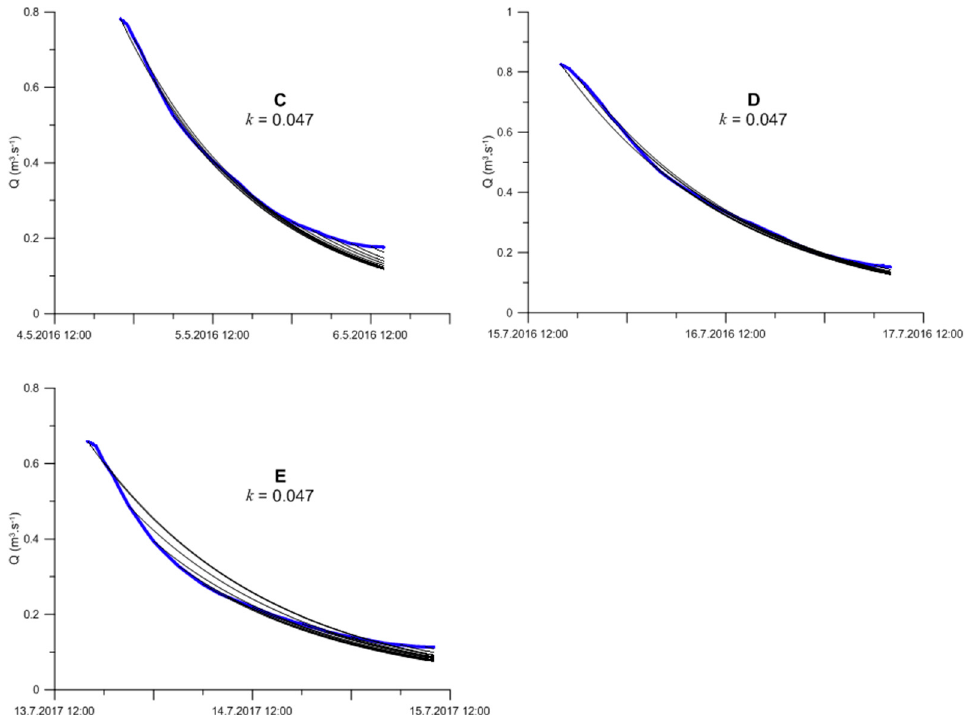
Figure 4. Plot of measured discharges (blue line) and discharges simulated using the global average value of recession constant for different starting points on the falling limb (black lines). Letters A to E relates to single events (see Table